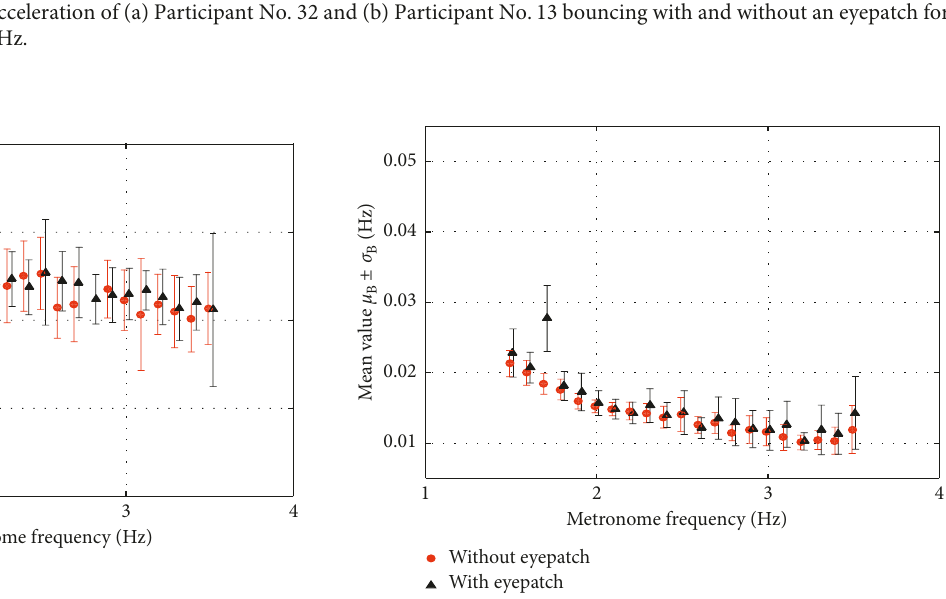
Figure 34: Comparison of the equivalent bandwidth for visual stimuli, with and without an